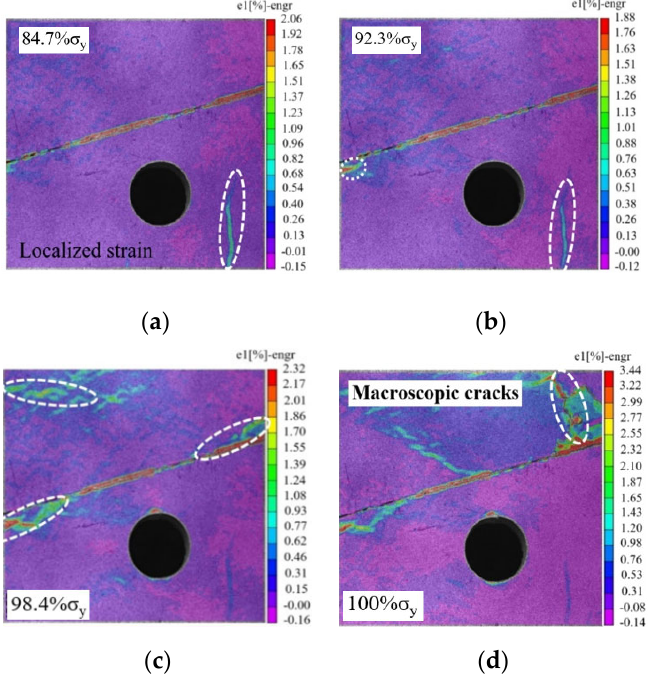
Figure 17. The displacement drops of different types of granite samples in group L. ( a ) The Horizontal displacement of samples; ( b ) The vertical displacement of samples.